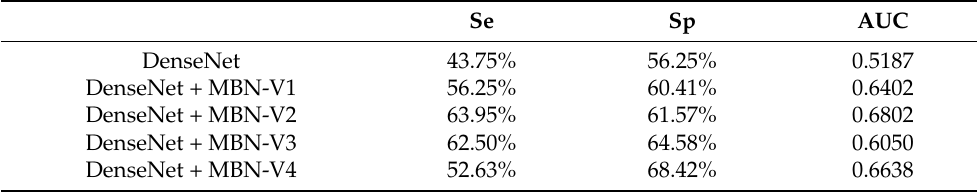
Table 4. Cancer classification result on mask loss with